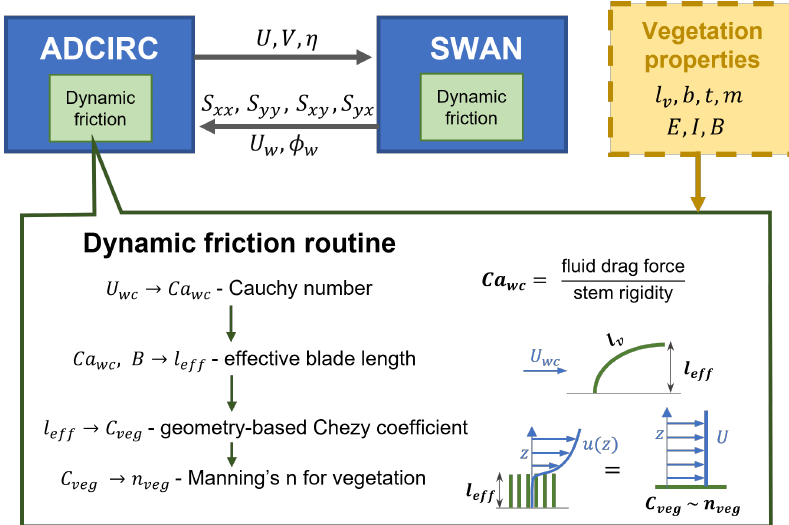
Figure 2. Dynamic bottom friction routine embedded into both ADCIRC and SWAN to capture vegetation